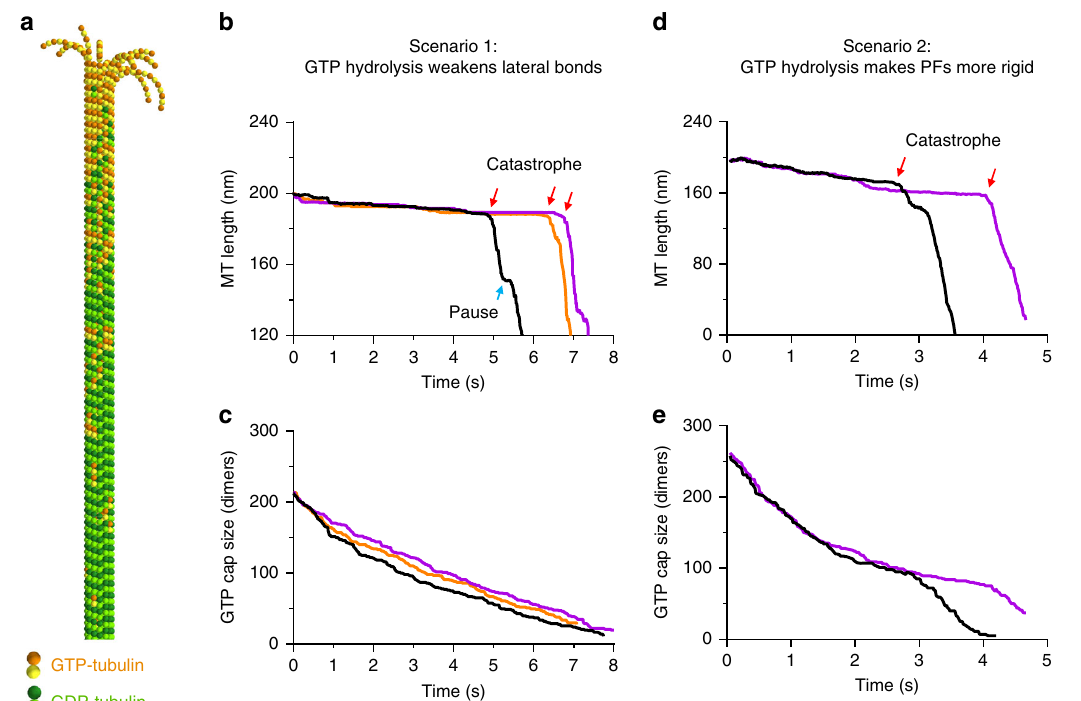
Fig. 3 Possible mechanisms of MT lattice destabilization by GTP hydrolysis. a Visualization of the starting con fi guration of an MT in the tubulin dilution simulations. GDP-bound tubulin dimers are shown with light and dark green spheres. GTP-bound dimers are shown with yellow and orange spheres. b Dependence of MT length on time in three independent repeats of the tubulin dilution simulation: PF bending stiffness is identical for GTP- and GDP-bound PFs and equal to 174 kcal mol − 1 rad − 2 ; lateral bond strength, b lat equals 8 and 4.7 kcal mol − 1 for GTP- and GDP-bound tubulins, respectively. Blue arrow indicates a brief pause of rapid GDP-MT lattice disassembly at a random GTP-tubulin remnant, which happened occasionally in some simulation runs (also see Supplementary Movie 3). c Dependence of the total number of remaining GTP-tubulin subunits on time in three independent repeats of tubulin dilution simulation from panel b . d Dependence of MT length on time in two independent repeats of tubulin dilution simulation: the lateral bond strength is set to 4.7 kcal mol − 1 , regardless of the bound nucleotide; PF bending stiffnesses are 78 and 174 kcal mol − 1 rad − 2 for GTP- and GDP-bound PFs, respectively. e Dependence of the total number of remaining GTP-tubulin subunits on time in two independent repeats of tubulin dilution simulation from panel d